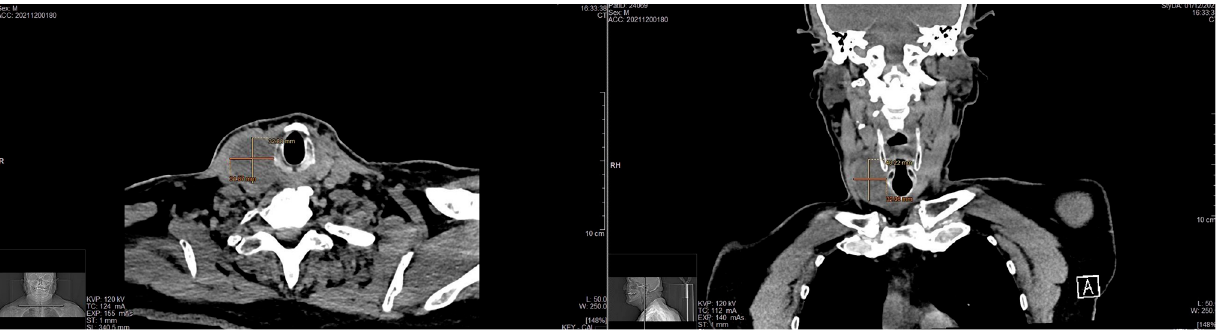
Figure 3. Fine-needle cytology of the neck lesion microscopically highlighting the presence of a three-dimensional solid group of fused cells in a hemorrhagic background, immersed in a metachromatic matrix, in the absence of a colloid component. The pathologists concluded that the mass was a Thyr 4 according to SIAPEC-AIT 2014 classification [12]. Therefore, considering the expected risk of malignancy (i.e., 60– 80%), the patient was recommended to undergo a right hemithyroidectomy. In December 2021, during surgery, after the dissection of the prethyroidal muscles, the presence of an extra-thyroidal neoplasm was highlighted, easily dissociable from the gland. It was carefully dissected and removed. However, considering the presence of a suspicious nodularity and the preoperative diagnosis of a Thyr 4, the right thyroid lobe and the isthmus were also removed. The hospitalization was regular with an absence of complications of phonation or signs of hypocalcemia, and, after 2 days, the patient was discharged. Surprisingly, definitive pathology showed the presence of normal multinodular colloidal parenchyma of the right thyroid lobe and the isthmus. Furthermore, the extra-thyroidal neoplasm measured 5 × 3.5 cm and showed mesenchymal proliferation, spindle-cells type, with both dense and loose areas with thickened walls vases (Figures 4 and 5). In dense areas (Antoni A), the so-called “Verocay bodies” were evident, while in the loosest areas (Antoni B), they appeared evident diffuse nuclear atypia (Figure 5). The Ki67 proliferation index showed a value lower than 5%; on immunohistochemistry, the protein S100 was positive while the relationship with actin was negative, concluding for a schwannoma (Figure 6). After 11 months, the patient was